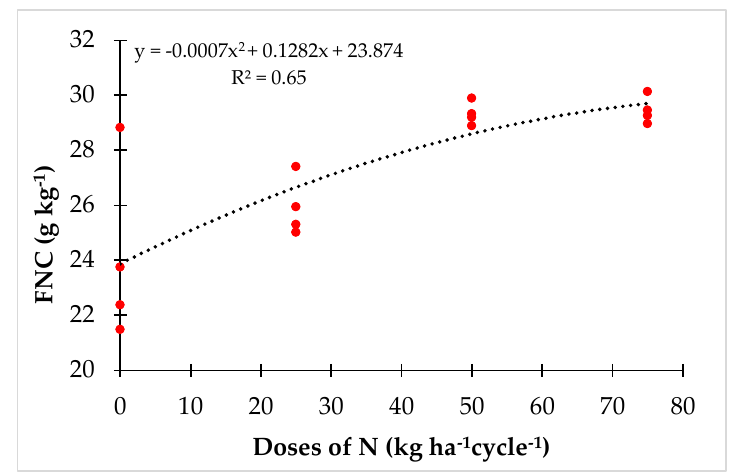
Agronomy 2019 , 9 , x FOR PEER REVIEW 11 of 24 from 5500 to 23,000 kg ha −1 and the values obtained for the Piãta and Decumbens grassland ranged from 400 to 4000 kg ha −1 . Figure 5. Foliar nitrogen content (FNC) values of Mombasa cultivar with di ff erent doses of N. Figure 5. Foliar nitrogen content (FNC) values of Mombasa cultivar with different doses of N.